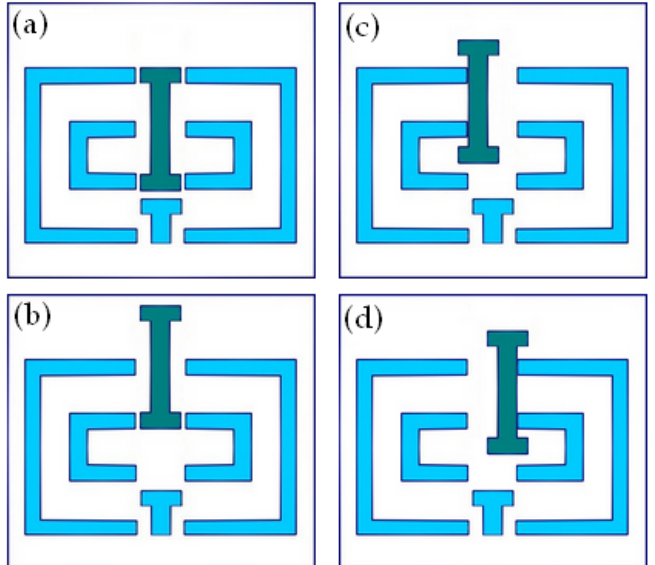
Figure 3. The maximum deflection points of the movable I-shaped metal bar in the X and Y axes: ( a ) the initial state of the bar, where deflection is equal to zero; ( b ) maximum swing of the moving column, 16 µm; ( c ) maximum leftward deflection in the X-axis, equal to 6 µm; ( d ) maximum rightward deflection in the X-axis, equal to 6 µm.